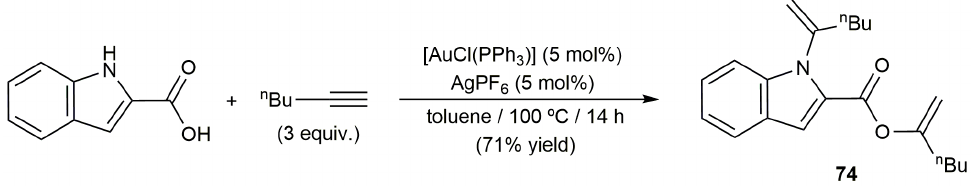
Figure 7. Structure of the water-soluble gold(I) complexes 75 .